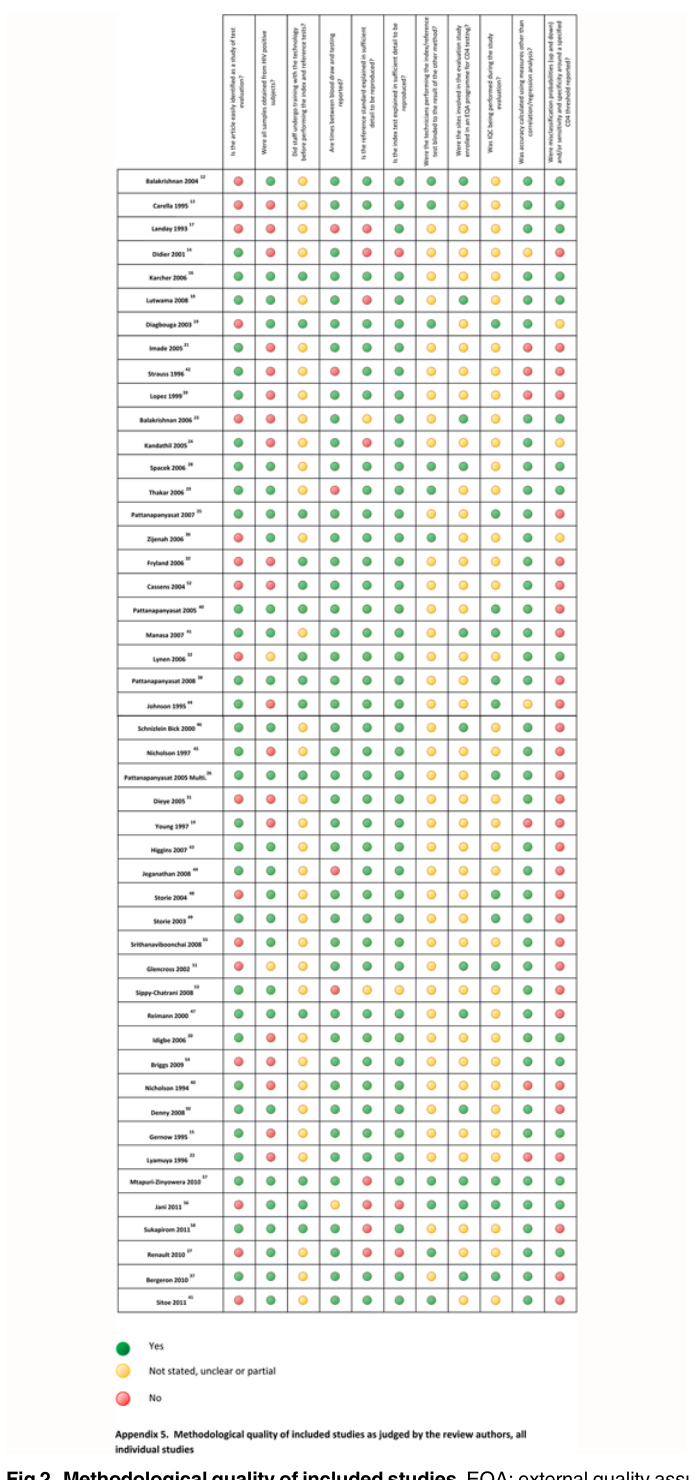
Fig 2. Methodological quality of included studies. EQA: external quality assurance, IQC: internal quality control.